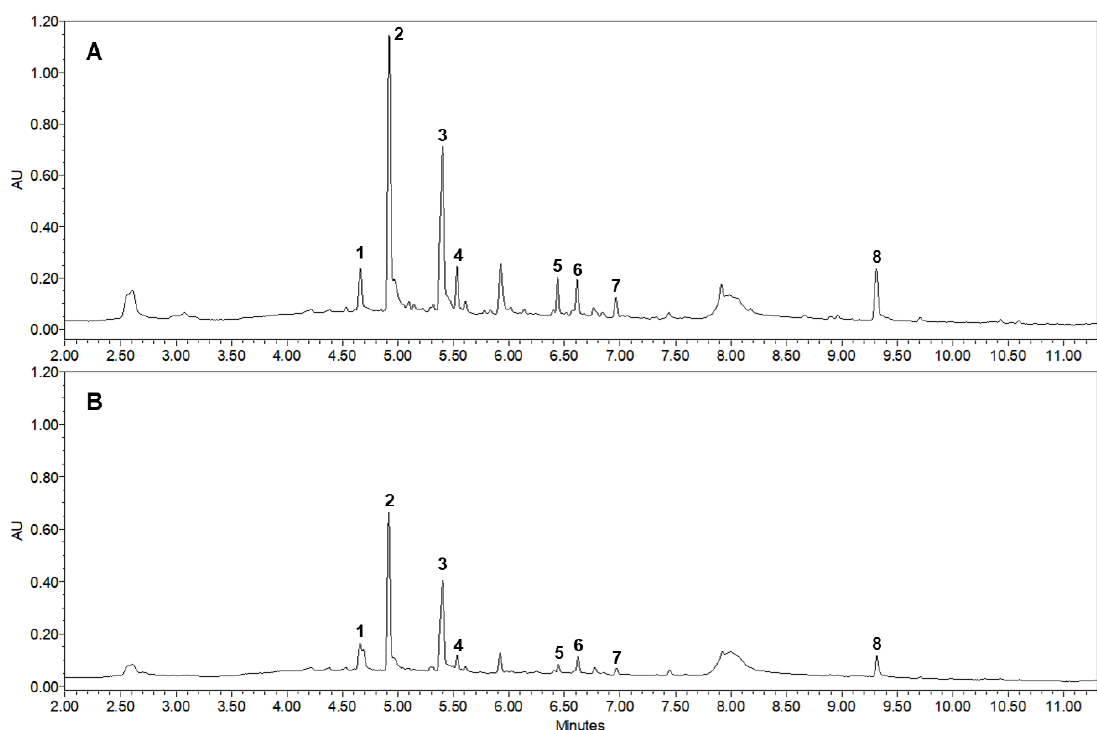
tagalloylglucose (4), isoliquiritin apioside (5), isoliquiritin (6), liquiritigenin (7), and glycyrrhizin (8).